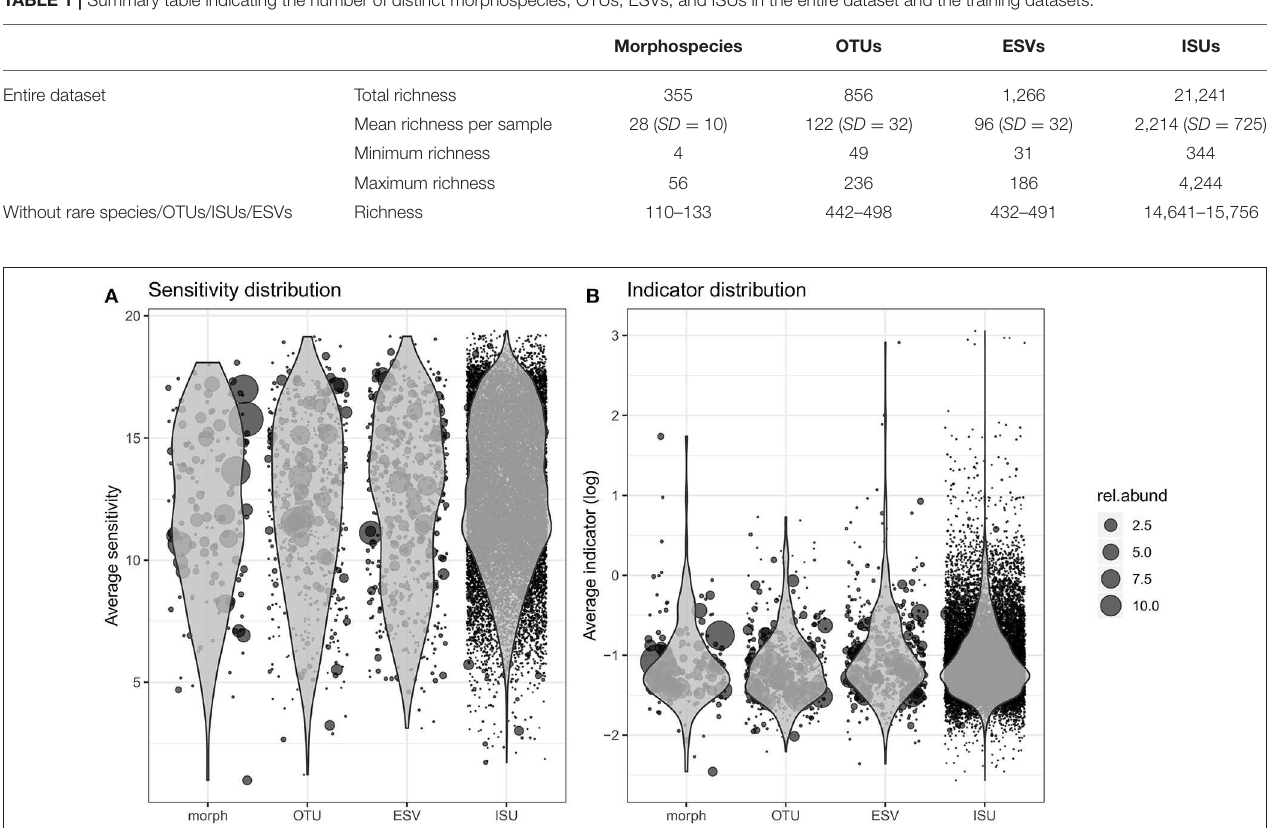
TABLE 1 | Summary table indicating the number of distinct morphospecies, OTUs, ESVs, and ISUs in the entire dataset and the training datasets.